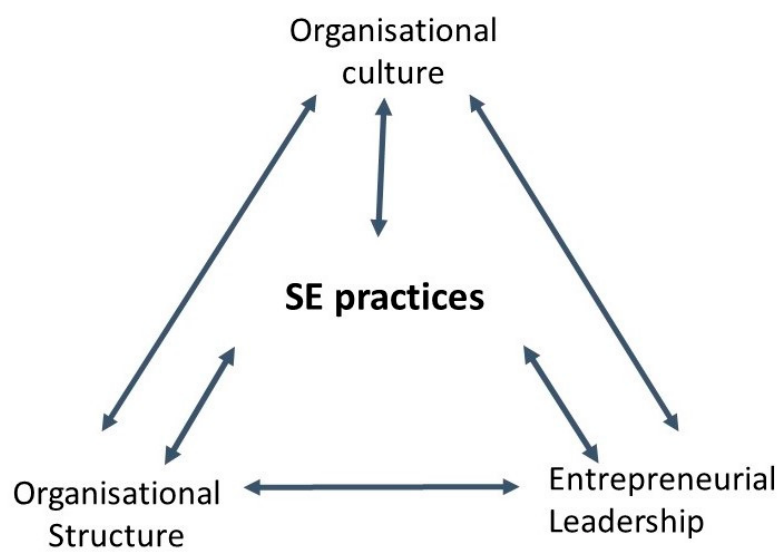
Figure 1. Strategic Entrepreneurship (SE) practices and their relationship to organisational culture, structure, and entrepreneurial leadership.